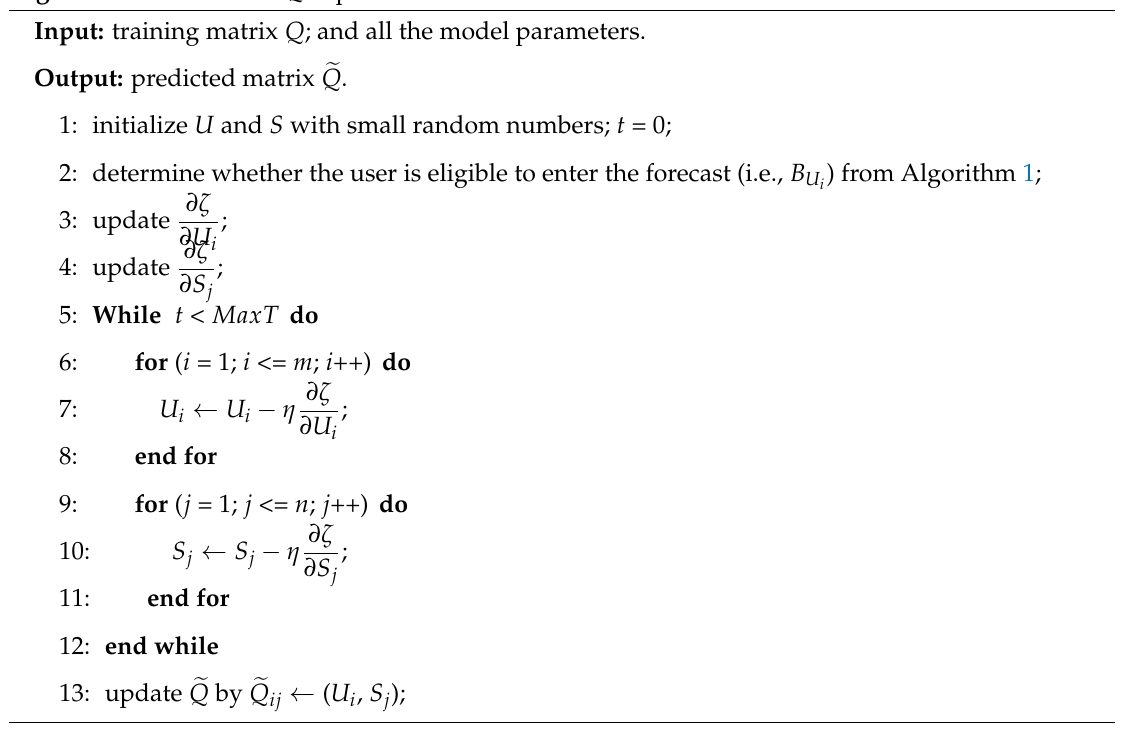
Algorithm 2 BMF-based QoS prediction